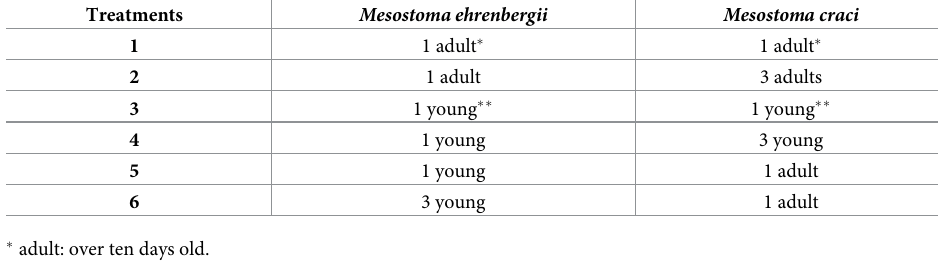
Table 1. Intrageneric predation by Mesostoma spp. at 24±1˚C, 6 treatments across 5 days.